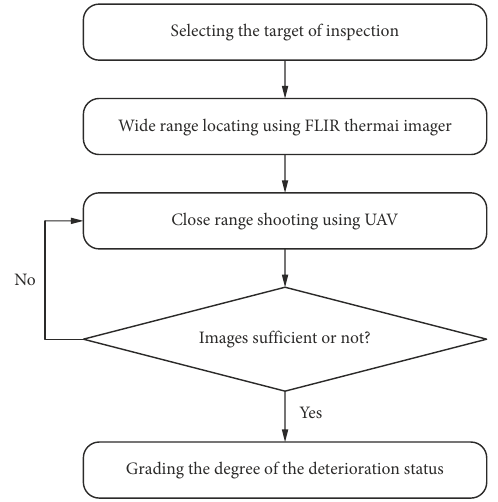
Figure 2. The process of the proposed model